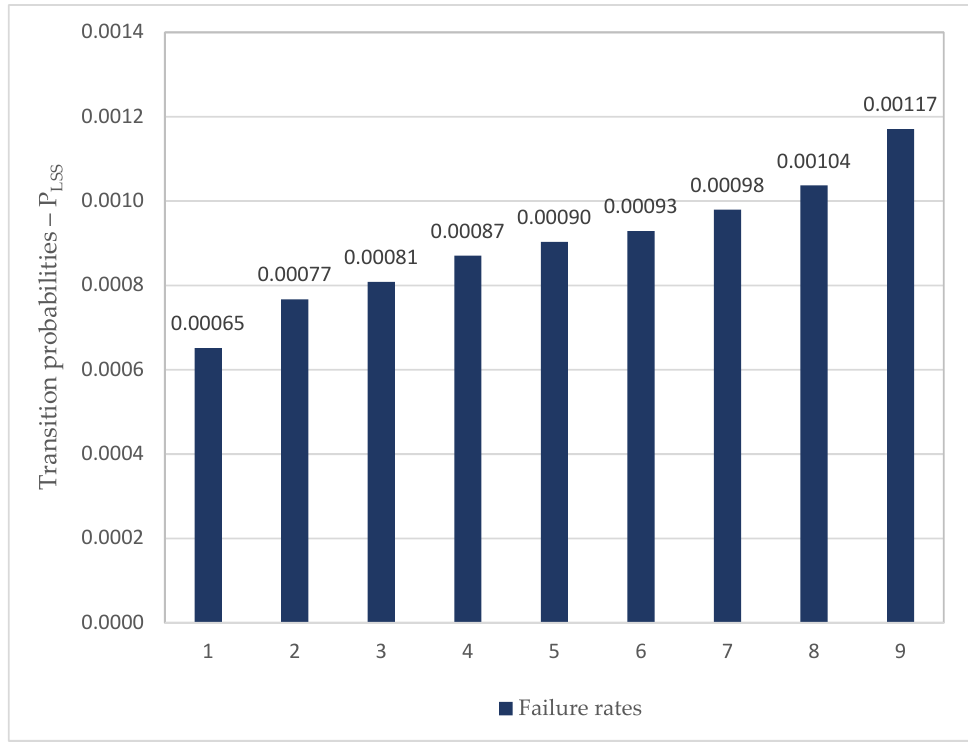
Figure 5. Dependence of the P LSS values on the failure rates λ CSS, λ TSS, and λ LSS acc. to Figure 2, for the constant µ TSS = 1.0399 d − 1 and µ LSS = 0.0276 d − 1